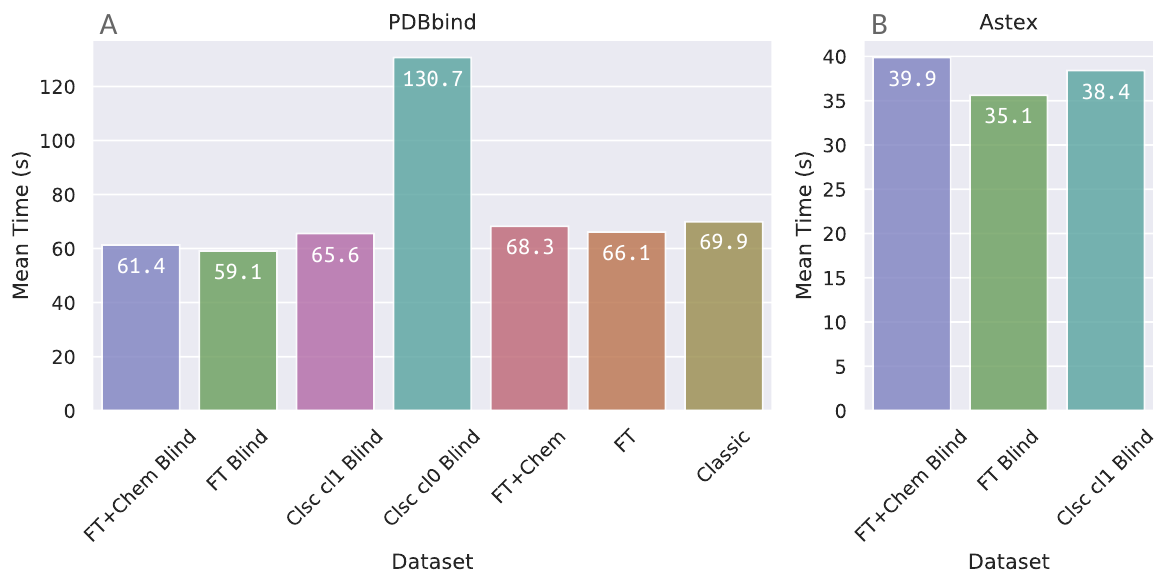
Figure 6. Mean elapsed time for each individual benchmarking protocol for docking in: ( A ) PDBbind Core Set; and ( B ) Astex Diverse